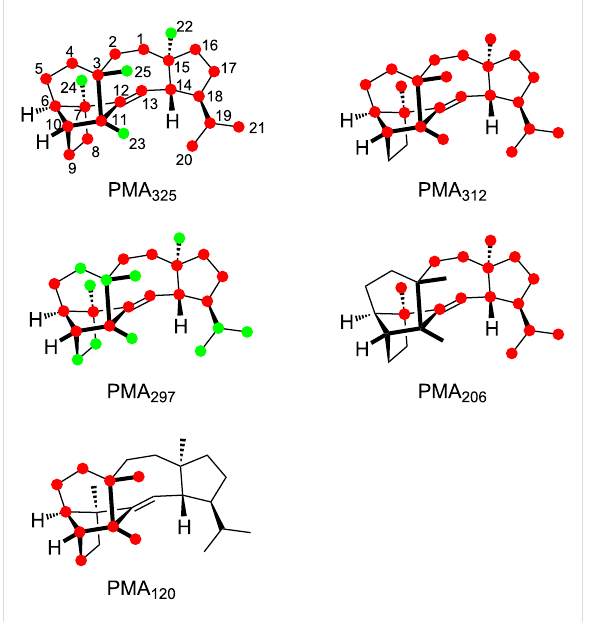
Figure 2: Position-specific mass shift analyses for 1 . Carbons that contribute fully to the formation of a fragment ion are indicated by red dots, partially contributing carbons are marked by green dots, and unlabelled carbons do not contribute and are thus cleaved off by the fragmentation